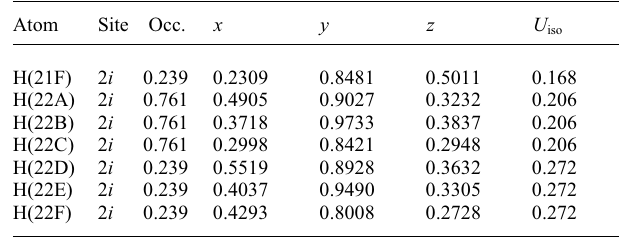
Table 3. Atomic coordinates and displacement parameters (in Å 2 )